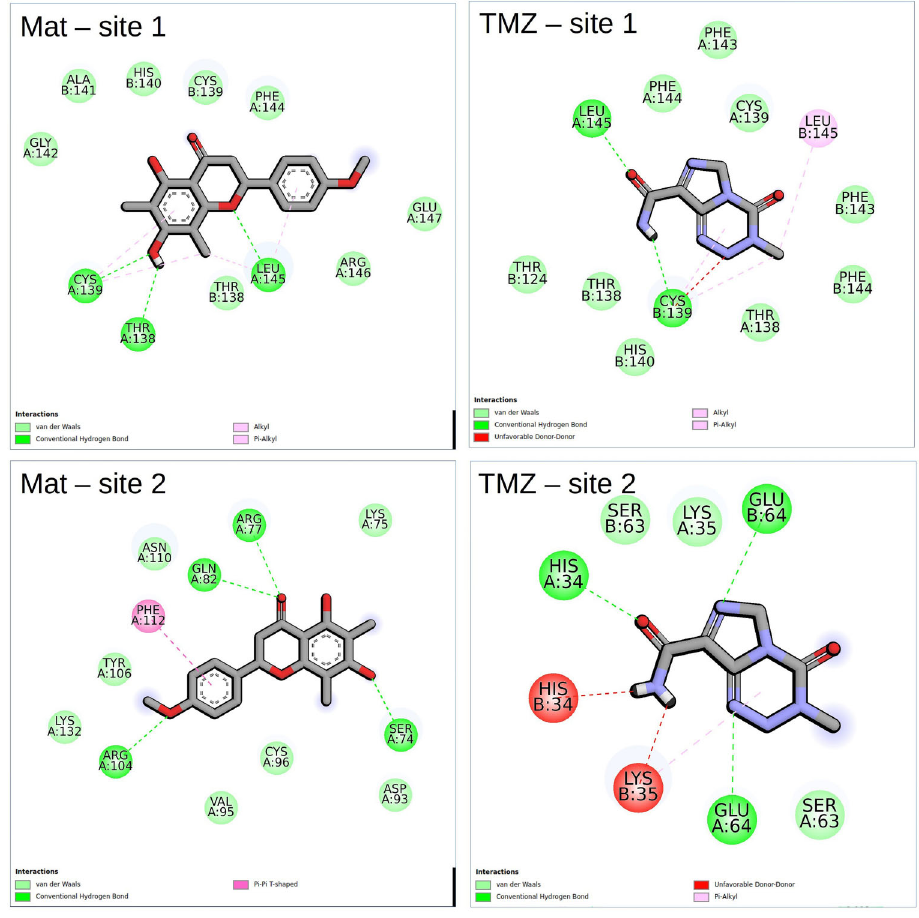
Figure 6. 2D interaction map of matteucinol (Mat), temozolomide (TMZ), and tumor necrosis factor receptor